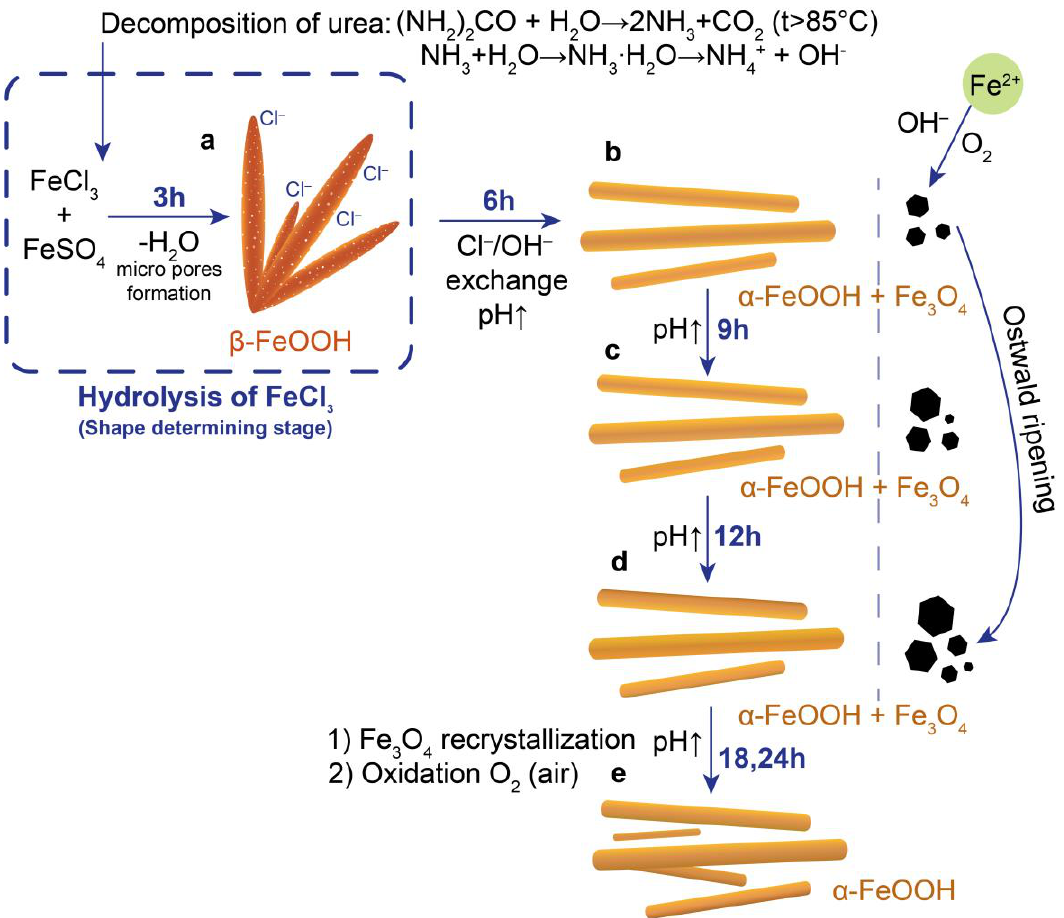
Figure 8. Pathway of iron derivatives transformations during co-precipitation of Fe 2+ and Fe 3+ salts via decomposition of urea after 3 ( a ), 6 ( b ), 9 ( c ), 12 ( d ), and 18-24 h ( e ) of the synthesis